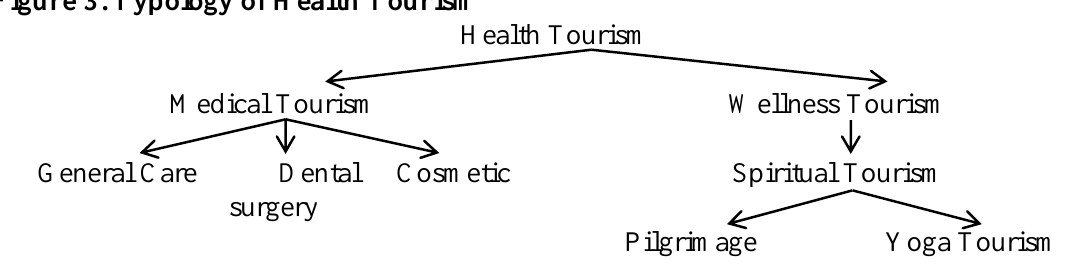
Figure 3. Typology of Health